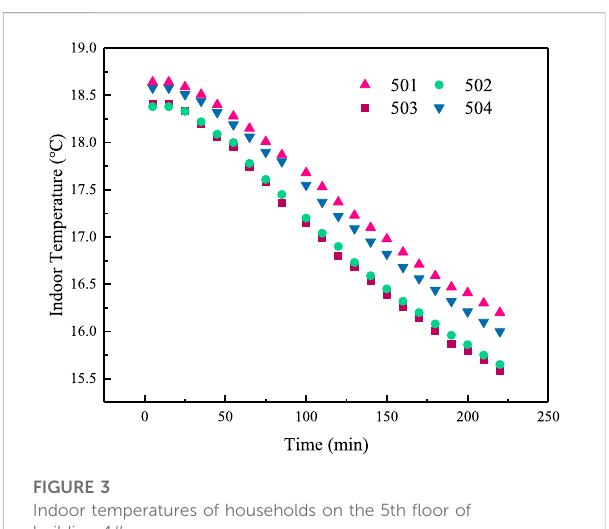
FIGURE 3 Indoor temperatures of households on the 5th fl oor of building 4#.